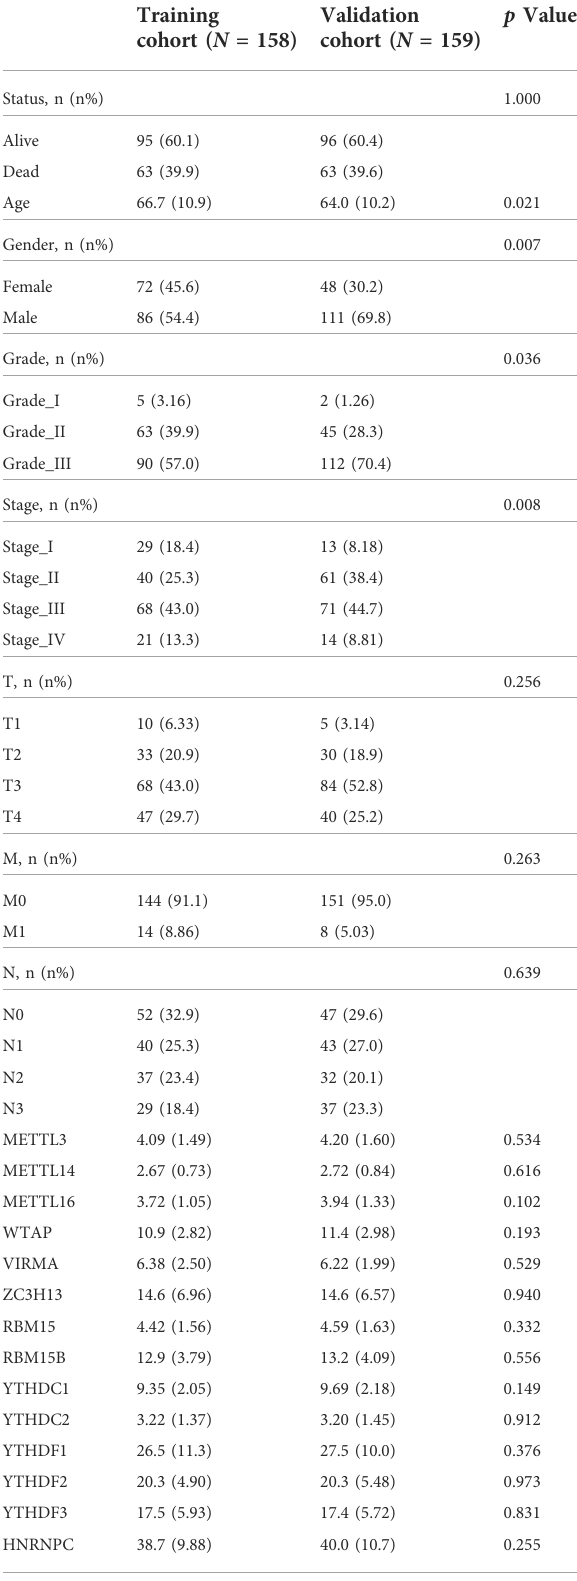
TABLE 1 Clinicopathological characteristics in GC patients.